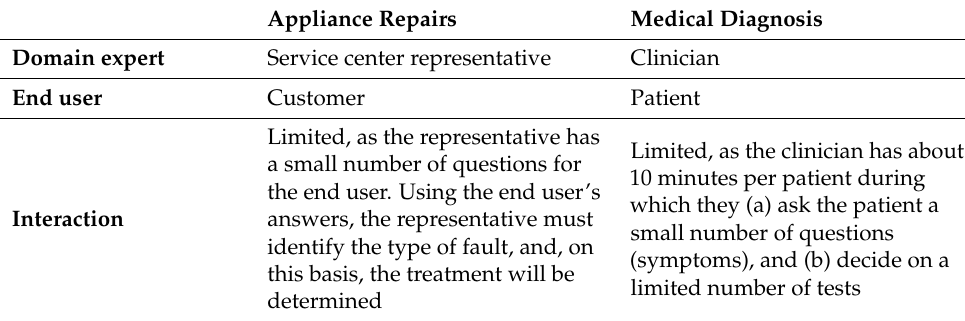
Table 1. Examples for domains with limited